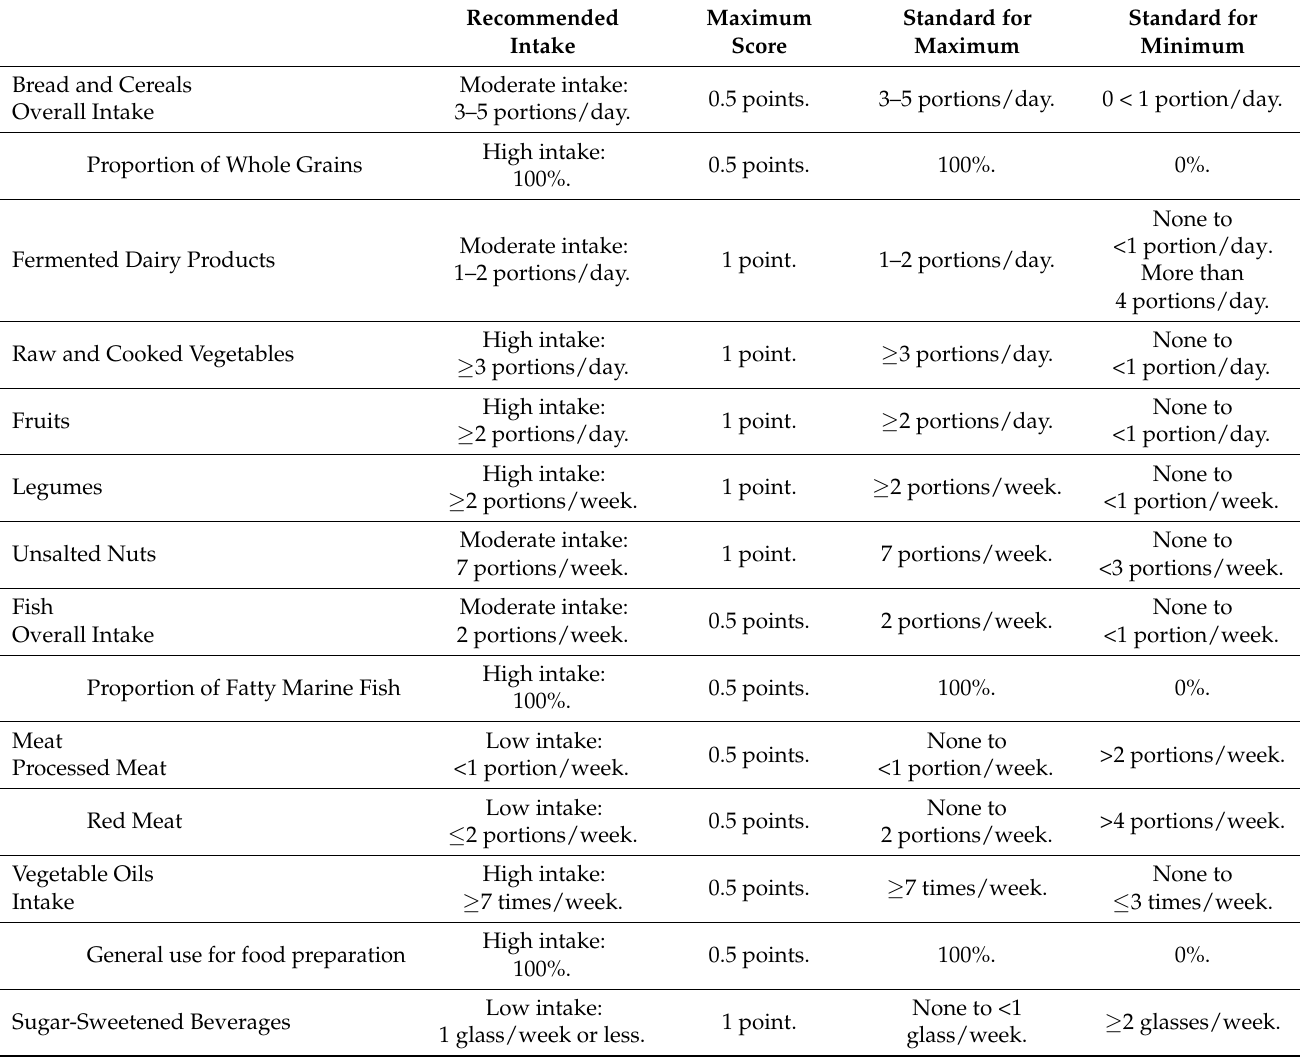
Table 2. Component food groups of the newly developed diet score and their scoring